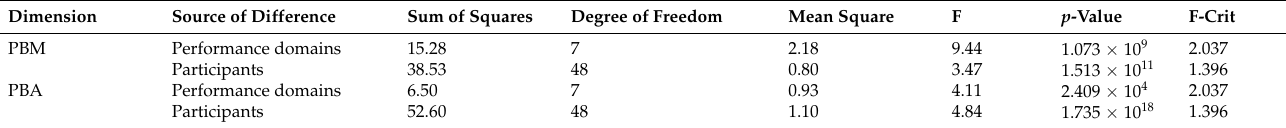
Table 6. Analysis of variance with two factors.